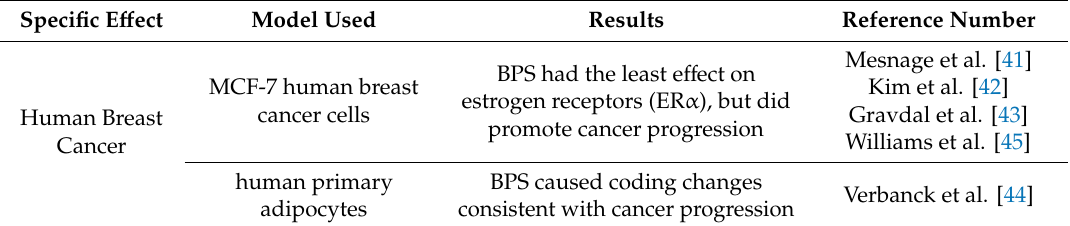
Table 3. Summary of Dietary BPS Exposure and Breast